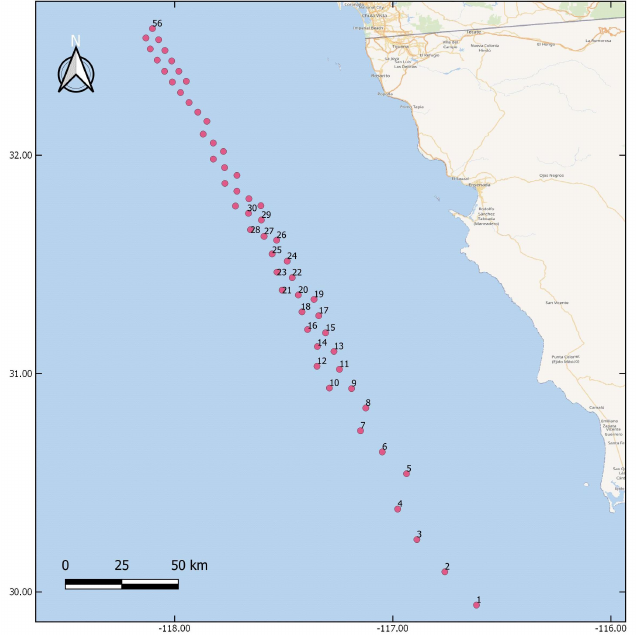
Figure 11. Location map of the computational nodes used as virtual buoys for the wave energy calculation. From node 1 to 30, the percentage of days in which energy remains greater than or equal to 2 kW/m is greater than 50% during the months with the highest